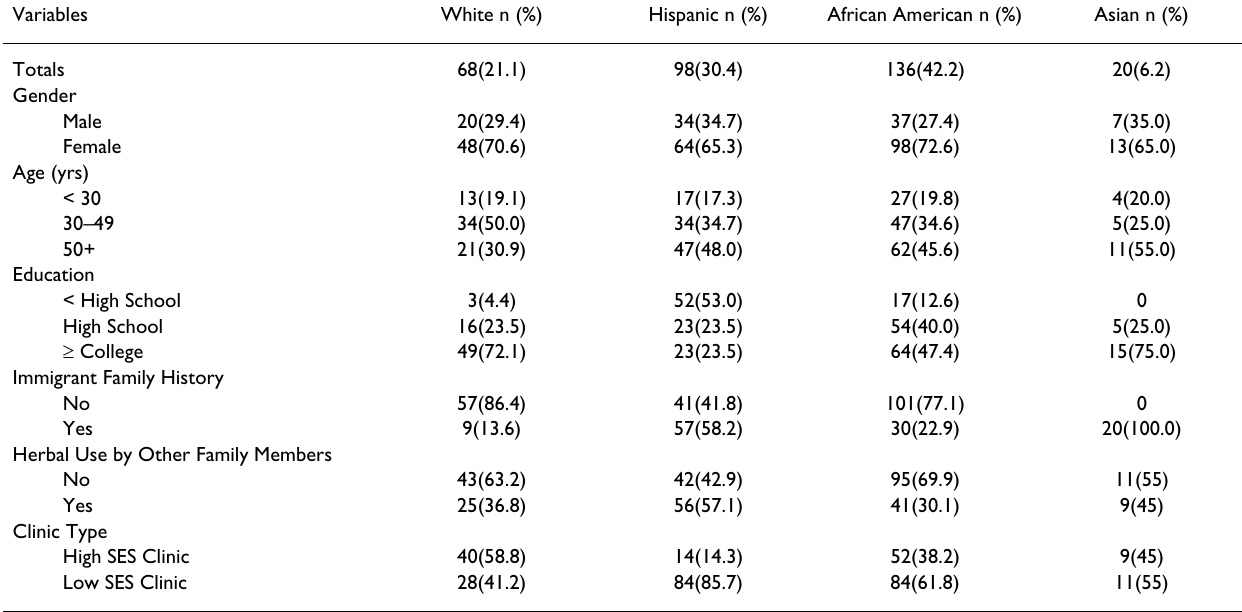
Table 1: Descriptive Characteristics of the Study Sample (n = 322)